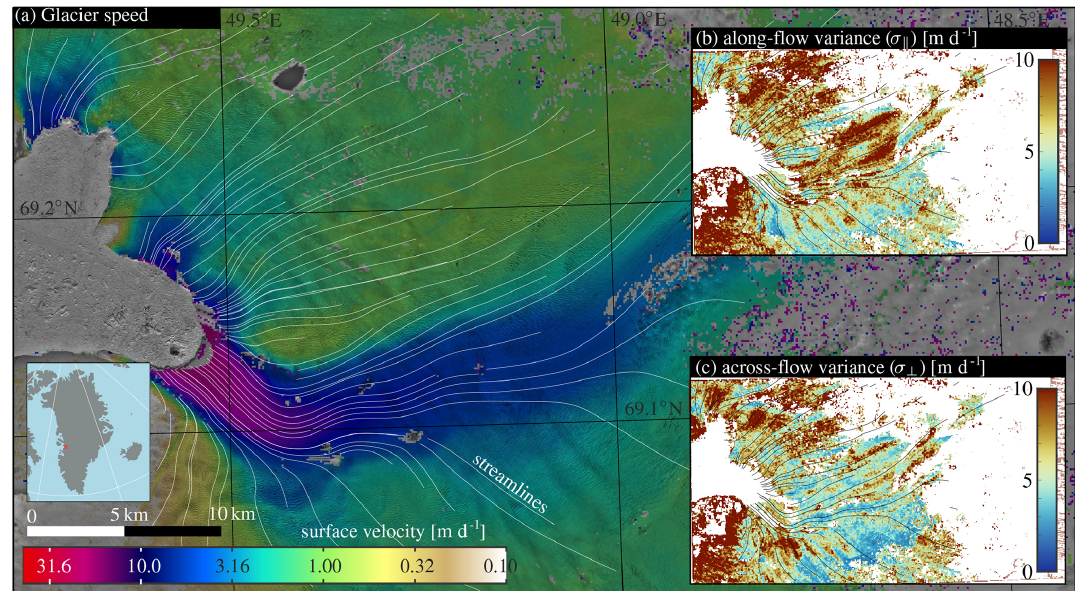
Figure 2. Color-coded speed and streamlines of Sermeq Kujalleq (Jakobshavn Isbræ) between 20 and 30 July 2020 based on Sentinel-2A imagery. The upper inset (b) shows the along-flow variance, while the lower inset (c) shows the across-flow variance.